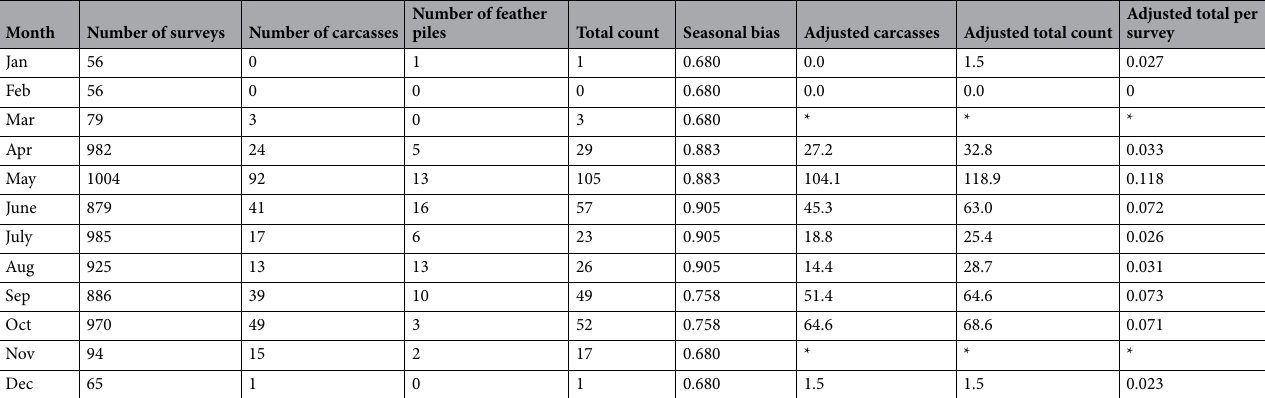
Table 3. Results of bird-window collision surveys. Raw counts and bias-adjusted estimates of fatal collisions by month based on collision surveys in Stillwater, Oklahoma, USA in 2015–2016. Bias adjustments incorporate seasonal estimates of searcher efficiency and scavenger removal rates of bird carcasses, and adjusted total counts are based on applying bias adjustments to raw counts excluding feather piles. *Surveys in March and November occurred more frequently than calculated in bias adjustments, so adjusted values would be overestimated for those months.